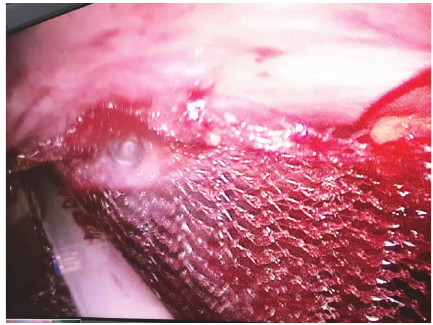
Figure 5: Fixation of mesh to anterior abdominal